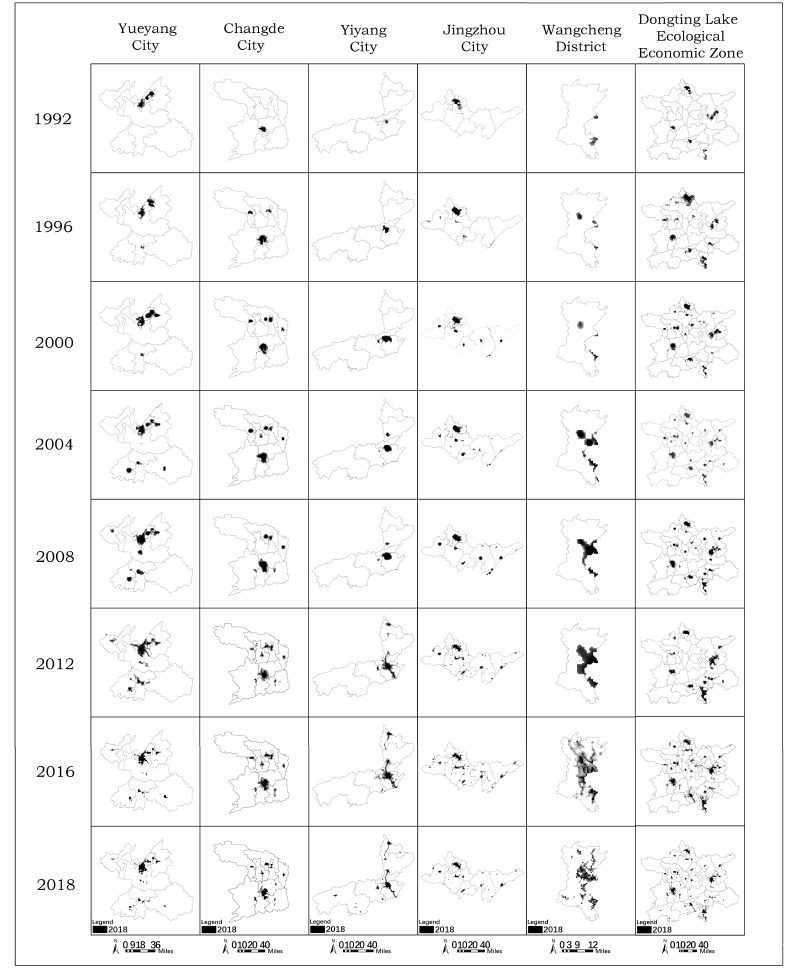
Figure 9. 27-year spatiotemporal expansion of UADLEEZ (four cities and one